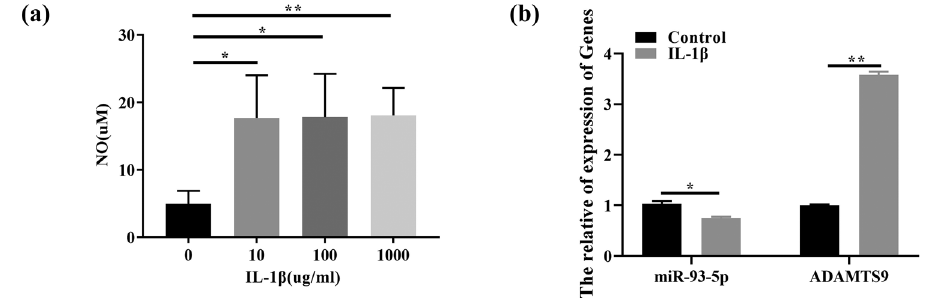
Figure 1: Construction of a mouse chondrocyte model of arthritis by IL - 1 β . Note: ( a ) when IL - 1 β concentration was 10 μ g/mL, the articular chondrocyte model of arthritic mice was constructed. ( b ) RT - qPCR was performed to detect the expression of miR - 93 - 5p and ADAMTS9 in IL - 1 β - induced chondrocytes. * P < 0.05; ** P <